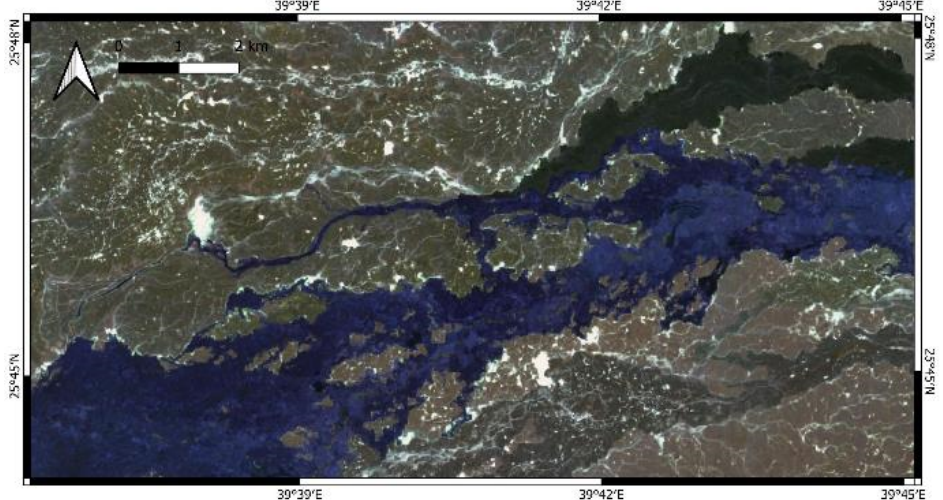
Figure 22. Typical distal lava flow field on a Sentinel SWIR satellite image clearly showing the narrow lava flow following a narrow and shallow dry valley within which it is captured. This narrow flow seemingly initiated from a ponded rubble p ā hoehoe zone, suggesting ready squeeze-out flow to be moved further. Note the large, chilled lava crusts (bluish shiny zones) partially fragmented and rotated by the movement of the flow.